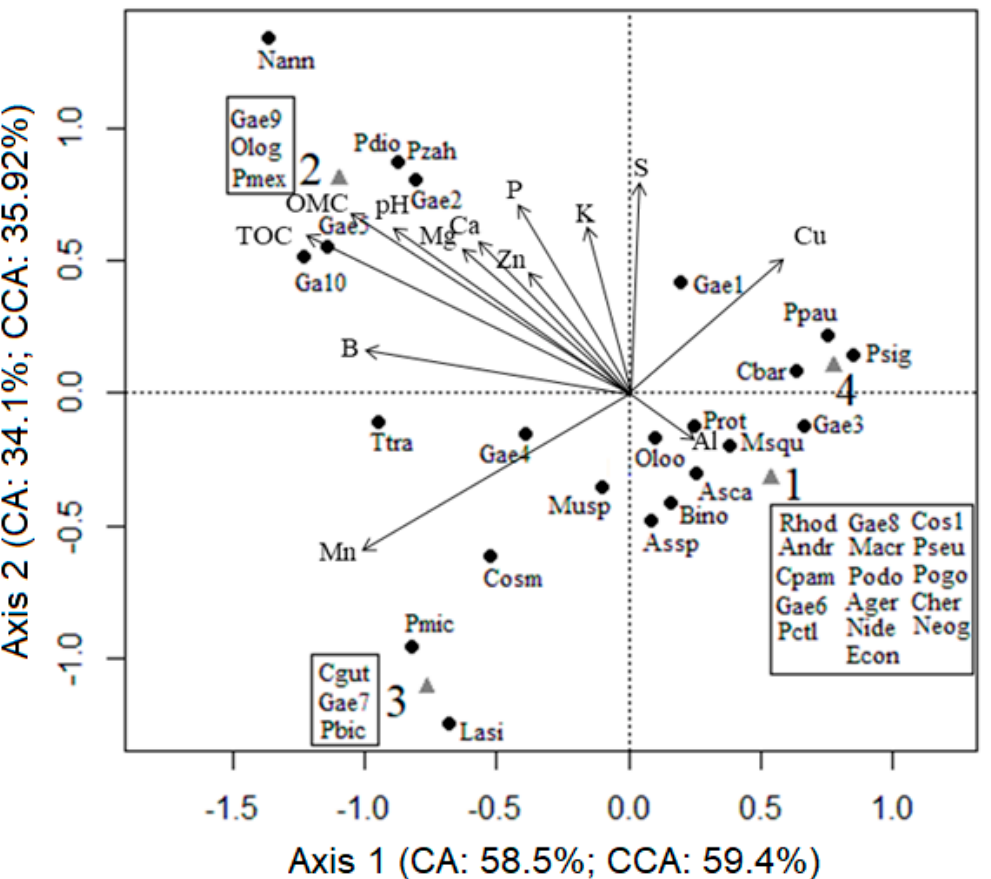
Figure 2. Biplot of simple and canonical correspondence analyses between the abundance of Gamasina and soil environmental parameters (pH; OMC, organic matter content; TOC, total organic carbon and chemical elements) in four ecosystems (1, natural vegetation; 2, soybean cultivation; 3 pasture; 4, integration of eucalyptus – pasture) at Sucupira, Tocantins, Brazil. Eigenvalues: CA: axis 1 = 0.59, axis 2 = 0.34; CCA: axis 1 = 0.59, axis 2 = 0.36. Habitats represented by triangles and species by circles. Species abbreviations shown in Table 2.